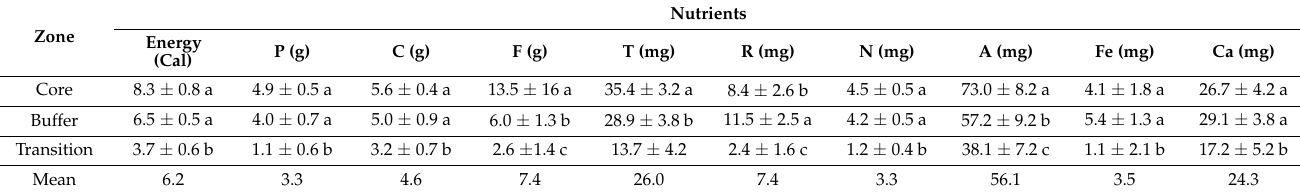
Table 5. Percent (%) contribution of wild edible foods (%) for energy and nutrients to diets consumed by indigenous communities of AABR, Central India.